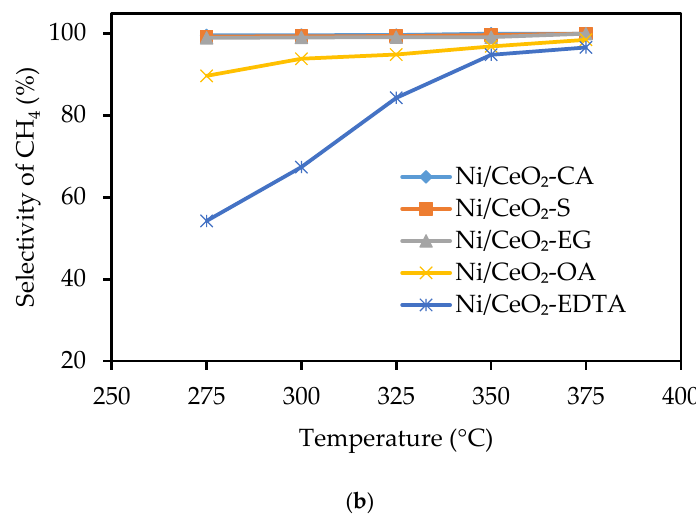
Figure 8. Effect of temperature on CO 2 conversion ( a , top) and CH 4 selectivity ( b , bottom) over Ni/CeO 2 with different chelating ligands: H 2 :CO 2 :CH 4 = 4:1:1, WHSV = 45 L/h g catalyst and pressure = 12.5 bar.